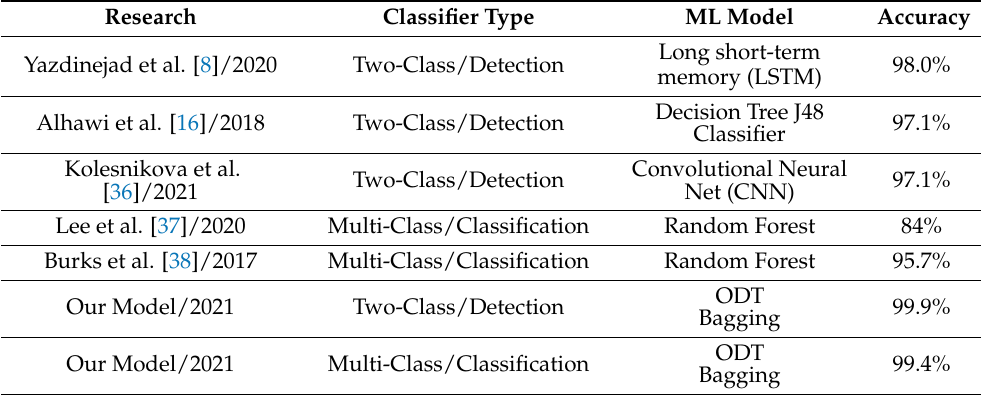
Table 4. Comparing our best accuracy results with other existing ML-based predictive